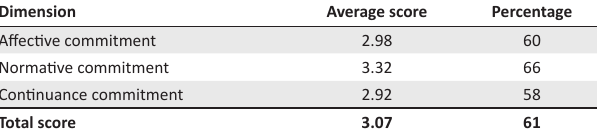
TABLE 4: Organisational commitment dimensions. Dimension